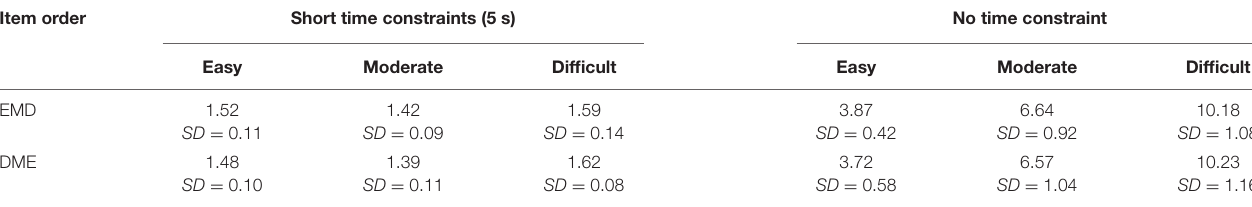
TABLE 5 | Self-paced study time in seconds for Experiment 3a (Ms, SDs). Item order